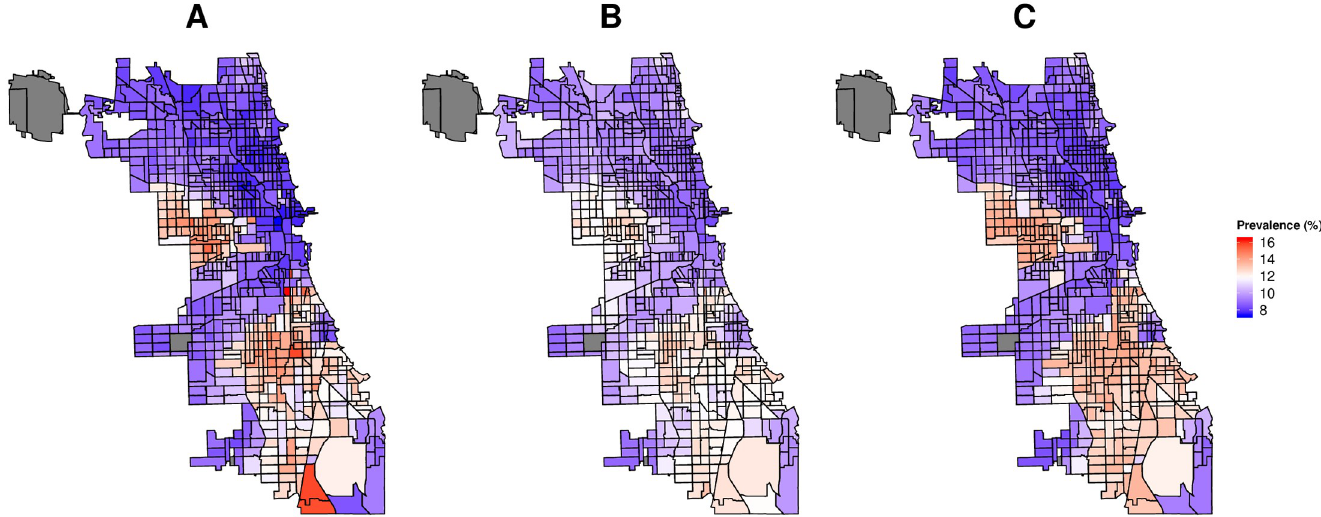
Fig 5. Census tract level prevalence of asthma for the city of Chicago in U.S. A: Ground truth as estimated by CDC. B: Estimates from search query based model. C: Estimates from model based on search queries, land cover and census data. Greyed areas show census tracts for which data was not available from any one of the data sources.